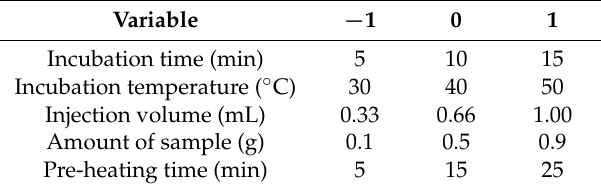
Table 1. Selected variables, their values and coded and un-coded levels used for the BBD.